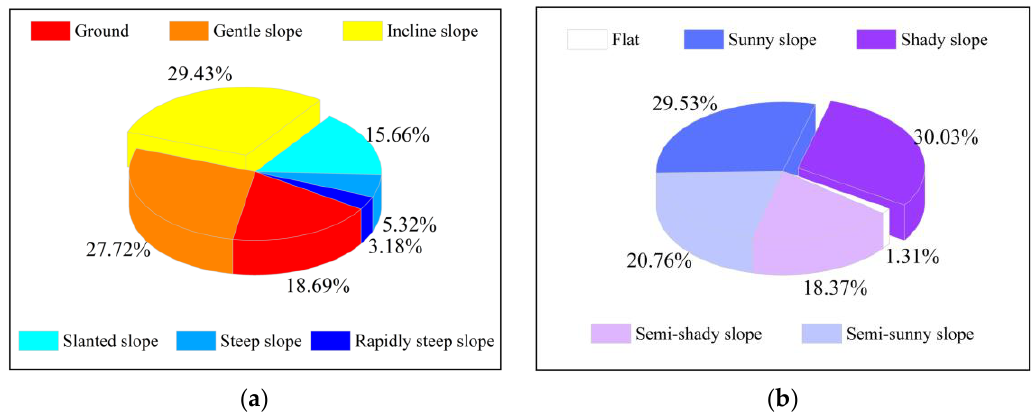
Figure 13. ( a ) Proportion of different slopes; ( b ) proportion of different aspects.